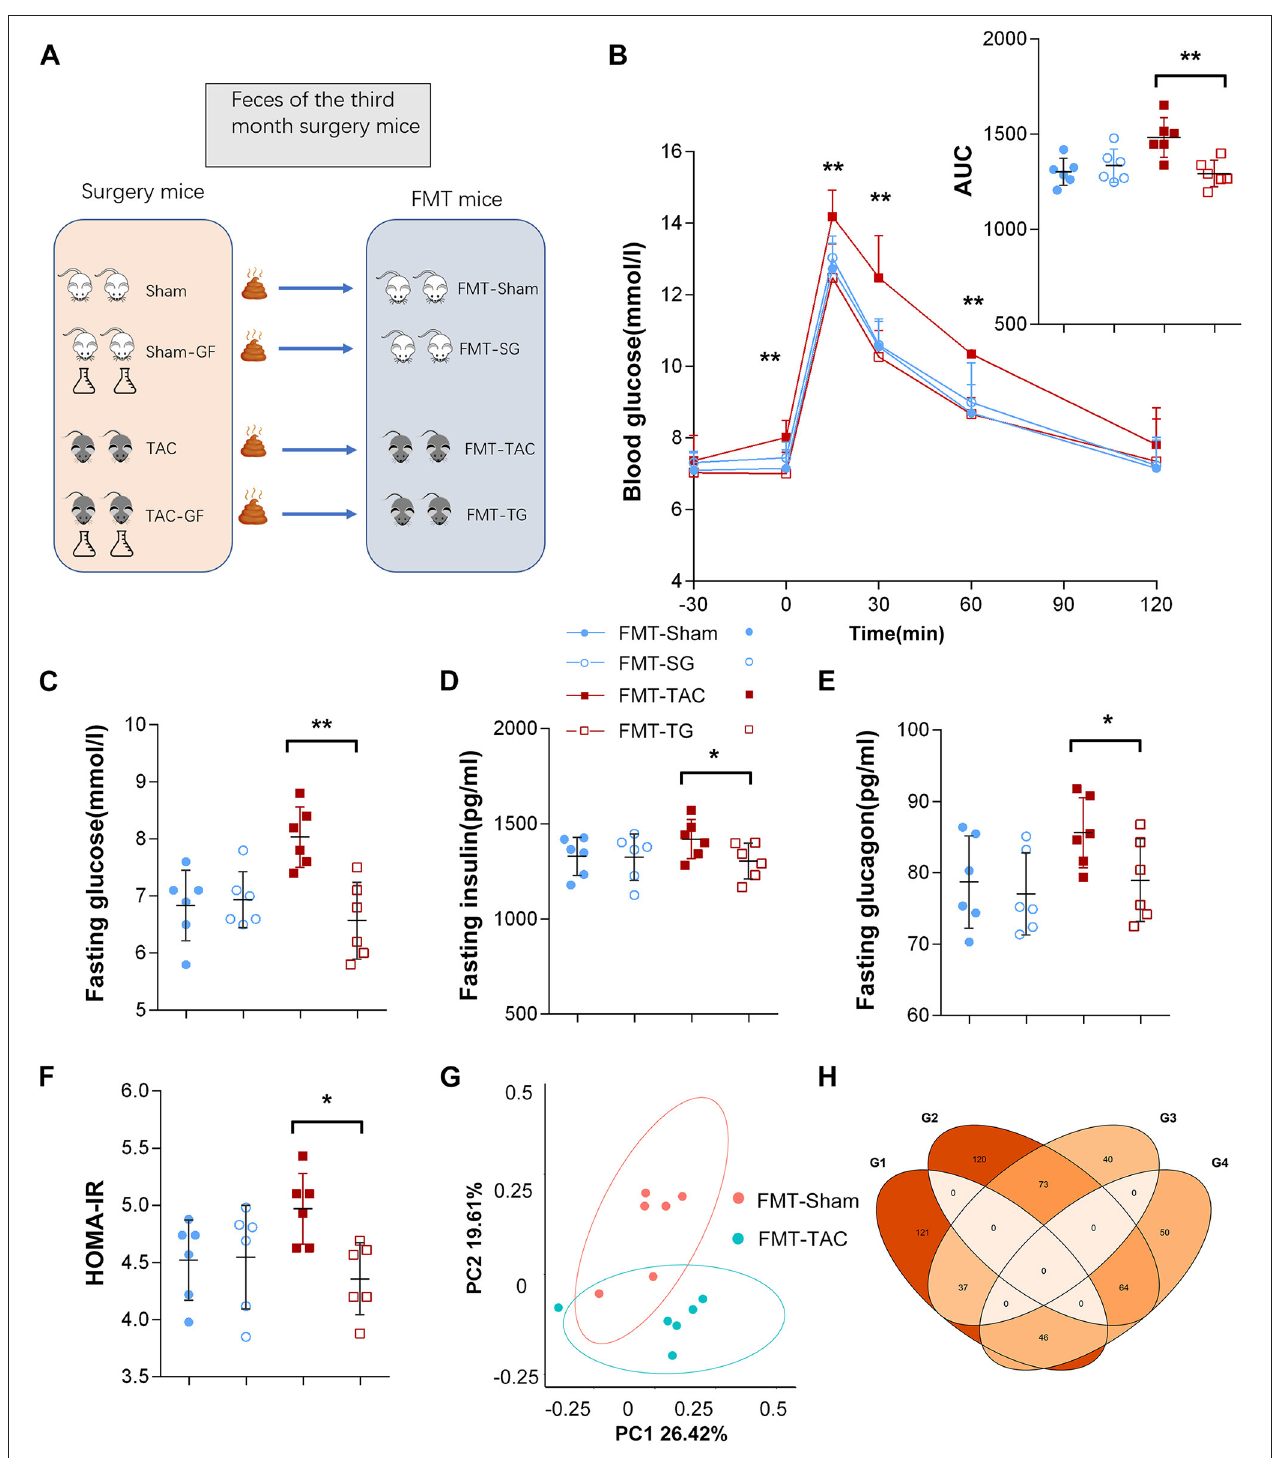
FIGURE 7 | Blood glucose was influenced by fecal microbiota transplantation (FMT). (A) Schematic diagram of the FMT design. (B) Intraperitoneal glucose tolerance test (IPGTT) in the FMT from the TAC (FMT-TAC), FMT from the TG (FMT-TG), FMT-sham, and FMT-SG groups. (C) Fasting glucose levels. (D) Fasting insulin levels. (E) Fasting glucagon levels. (F) Homeostasis model assessment for insulin resistance (HOMA-IR) values. (G) Principal coordinate analysis (PCoA) of β diversity analysis based on Bray-Curtis distances. (H) Donor mice and recipient mice share the same upregulation and downregulation of microbiota. G1–G4 represent donor upregulation, donor downregulation, recipient upregulation, and recipient downregulation, respectively. * p < 0.05, ** p < 0.01.